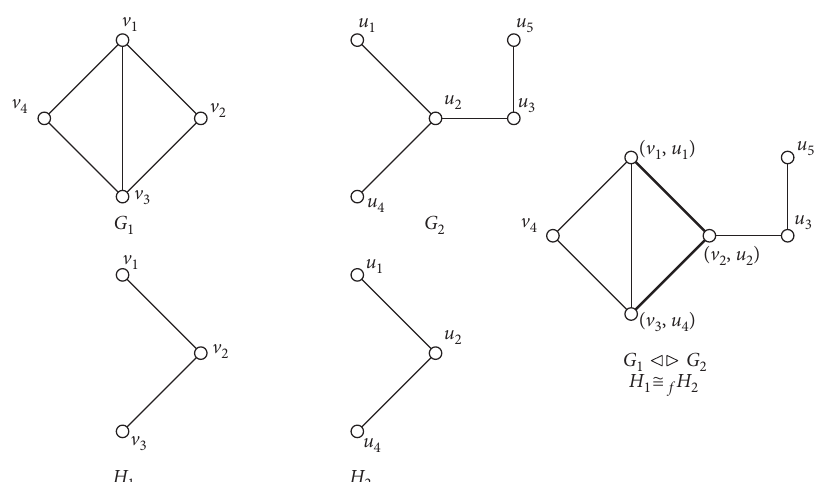
Figure 1: An amalgamation of G